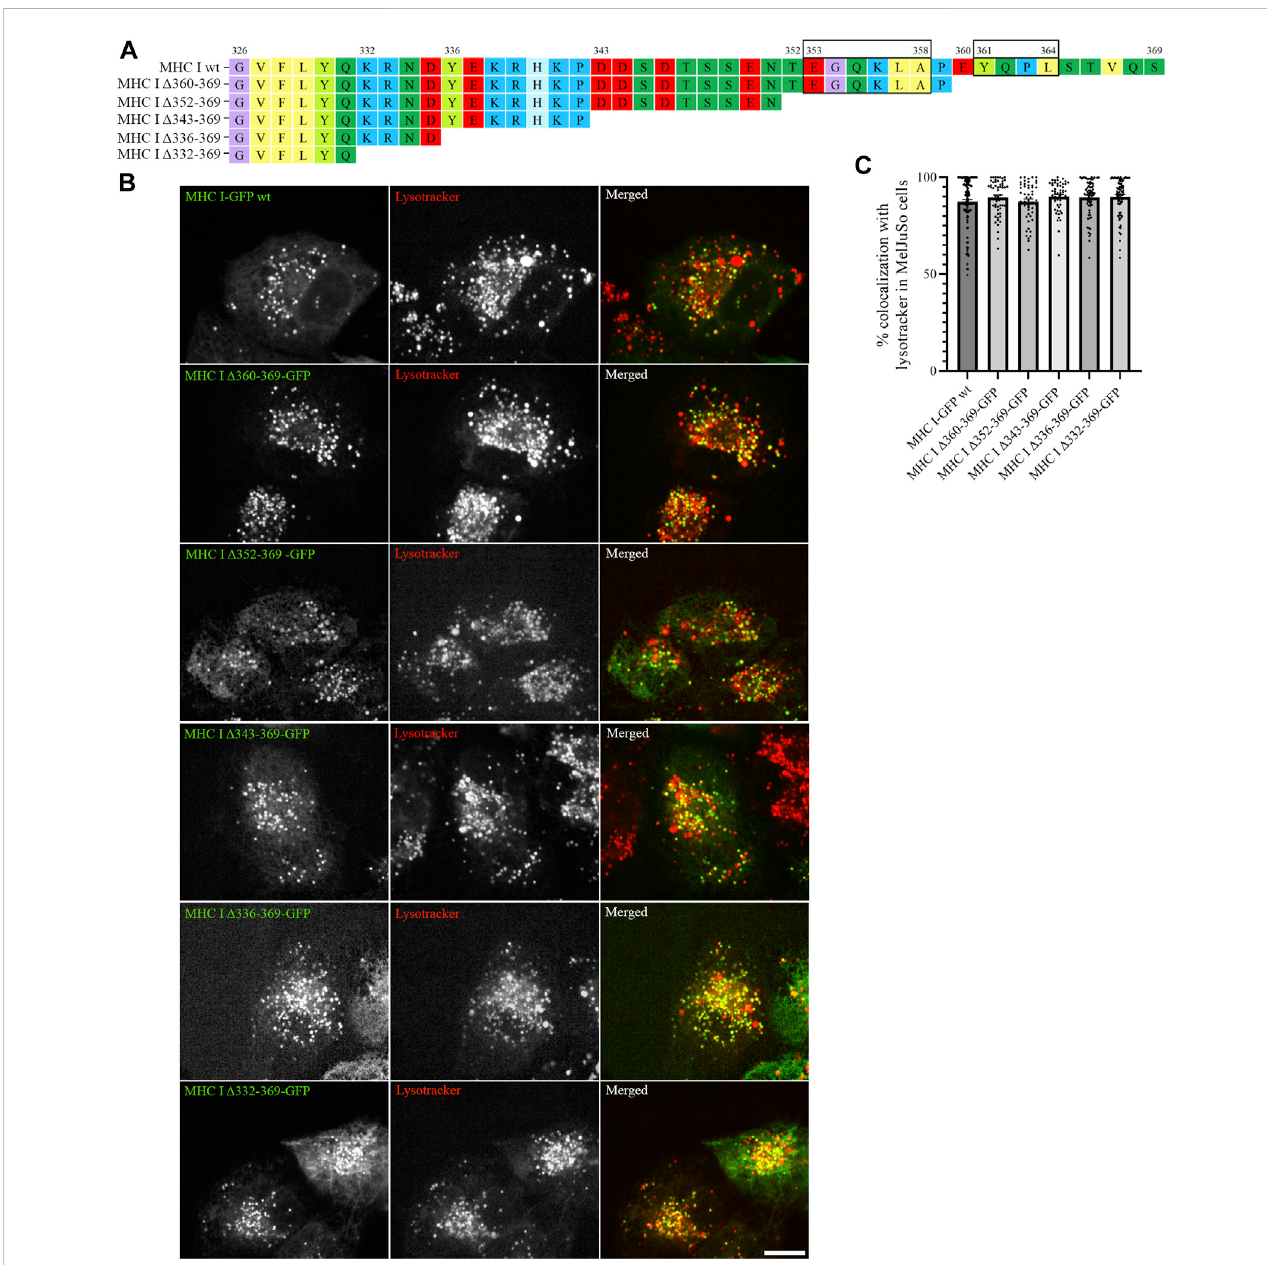
FIGURE 3 Cytosolic tail deletion mutants of Atlantic cod MHC I variant 1 do not affect its intracellular localization in MeljuSo cells. (A) Amino acid sequences of Atlantic cod MHC I variant 1 wt and its fi ve deletion mutants. Putative dileucine and tyrosine sorting signals are boxed. Numbers above the sequences mark amino acid positions. (B) Representative imagesof MelJuSo cells transiently transfectedwith Atlantic cod MHC I-GFP variant 1 wt or the fi ve deletion mutants (green). The cells were stained with lysotracker red and imaged using an Andor Dragon fl y spinning-disk confocal microscope. Colocalization between green and red channels results in yellow signal in the merged panels. Scale bar: 10 μ m. (C) The graph represents the percentage of colocalization between Atlantic cod MHC I variant 1 wt or the fi ve deletion mutants and lysotracker red. Colocalization was done by object-based analysis using ImageJ software. Values represent the mean ± s.e.m. from at least three independent experiments. n ≥ 53 cells. Non-signi fi cant (Two-tailed paired Student t